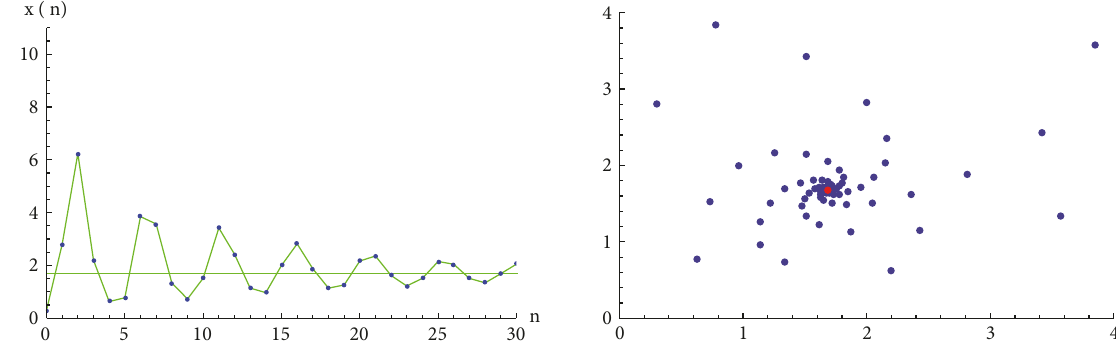
Figure 9: The orbit and phase portrait for 𝑐 = 2, 𝑏 = 1,𝐵 = 4 , 𝐹 = 3 , 𝐹 0 = 8 , 𝐹 𝑔 = 128 , and (𝑥 0 , 𝑥 −1 ) = (0.3,2.8) generated by Dynamica 4